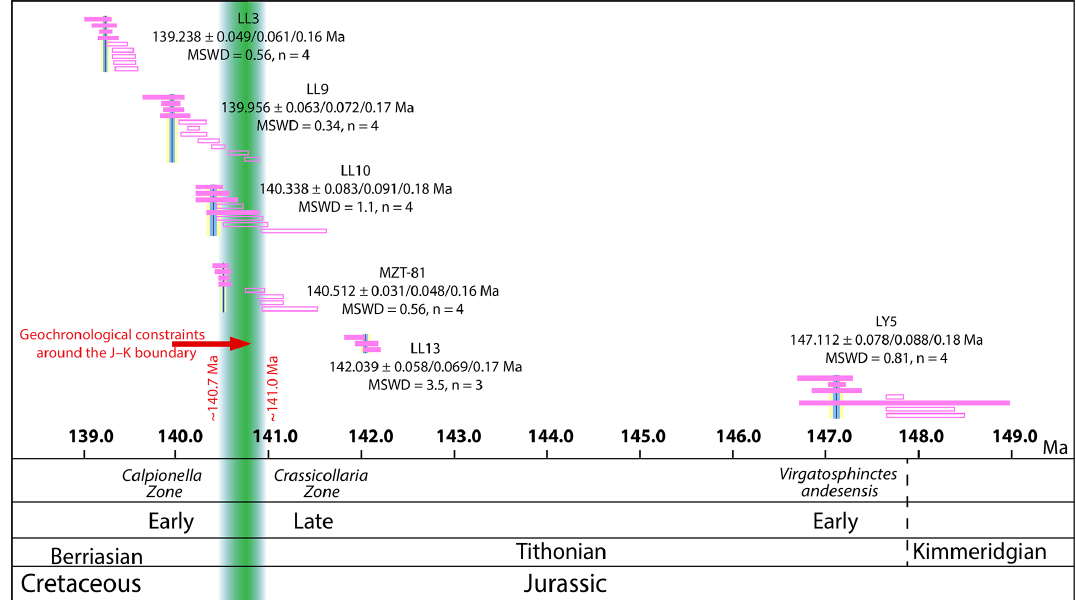
Figure 4. U–Pb-weighted mean ages of the dated ash beds and the ages and projected ages of the J–K boundary interval, the base of the Calpionella alpina zone, the top of the Crassicollaria Zone, the Virgatosphinctes andesesis zone, and the KmTB at ∼ 148Ma. Color bars represent grains considered in the weighted mean